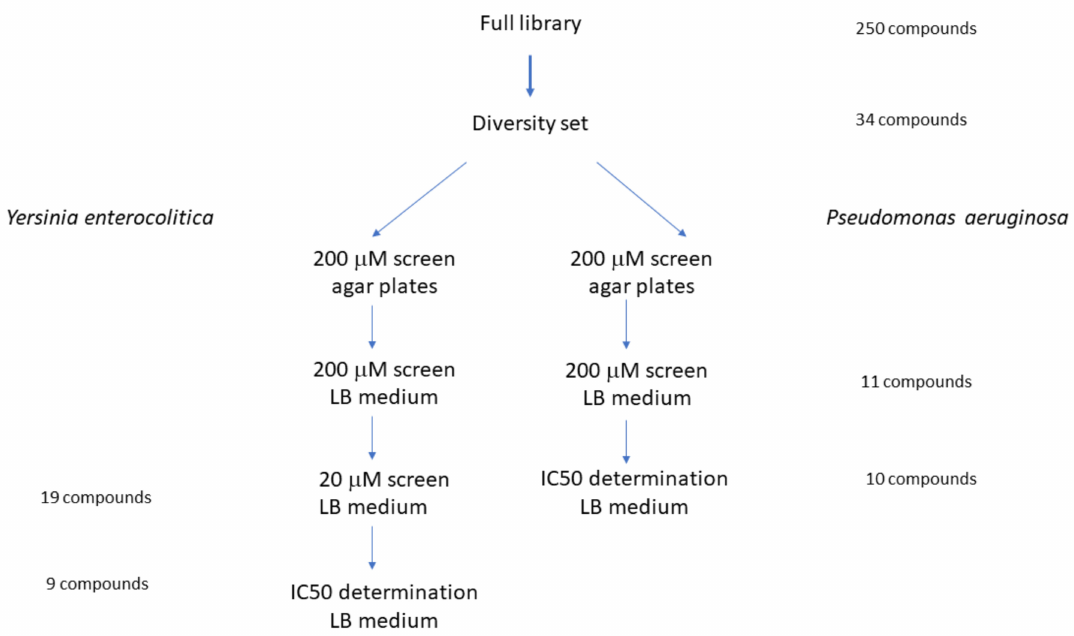
Figure 1. Screening strategy of small compounds library against P. aeruginosa and Y. enterocolitica . A diversity set of the complete library was screened on LB agar plates and then in a liquid medium as described under Materials and